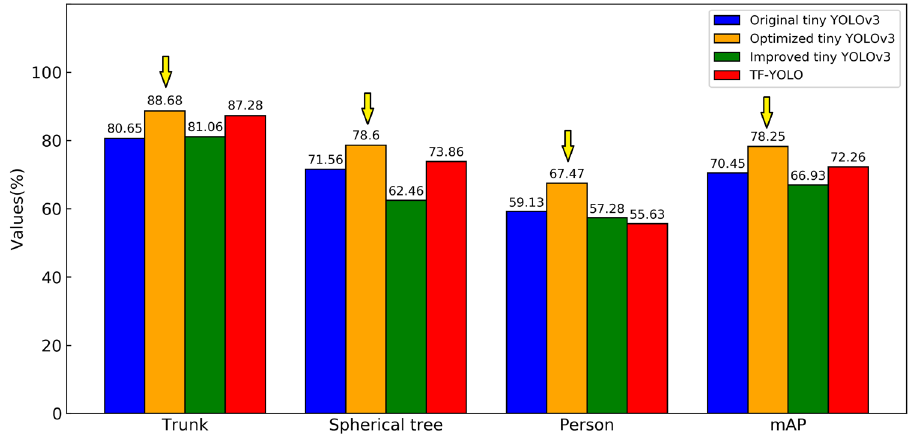
Figure 9. AP and mAP values on the testing set.